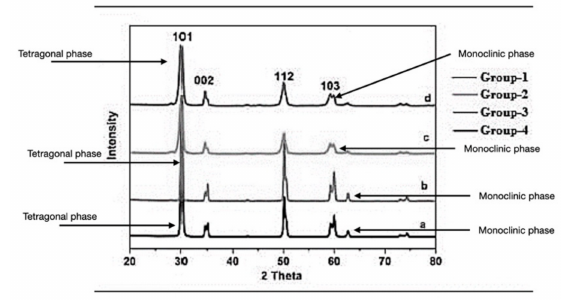
Figure 7. Patterns of X-ray diffraction of all tested